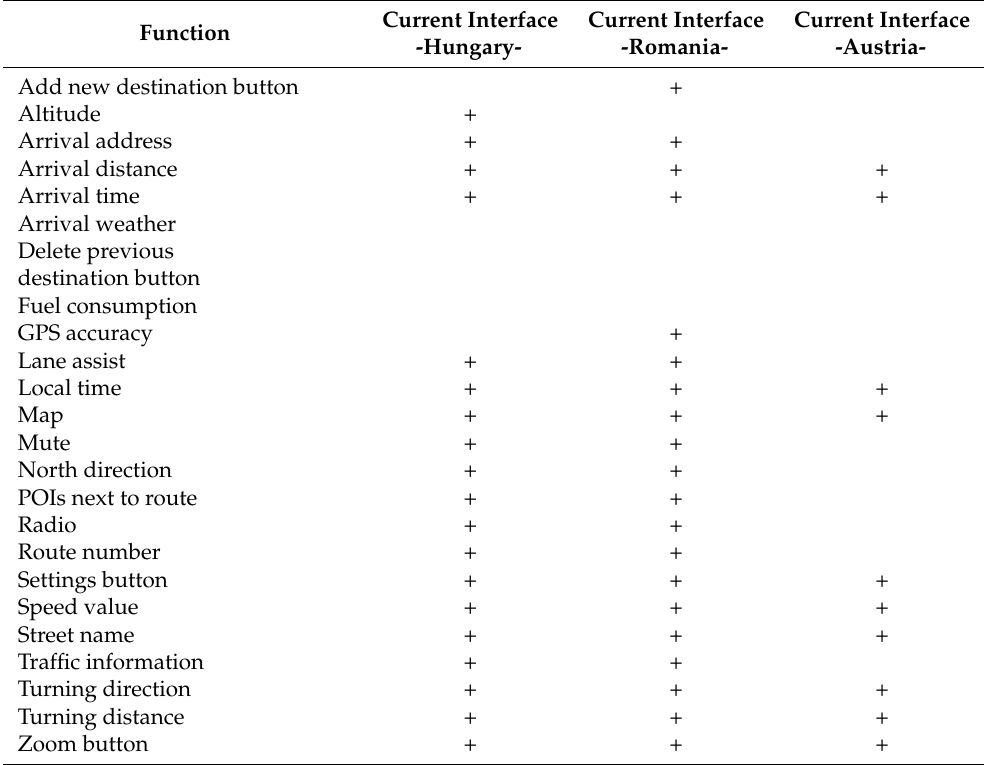
Table 3. Optional features and their current appearance by